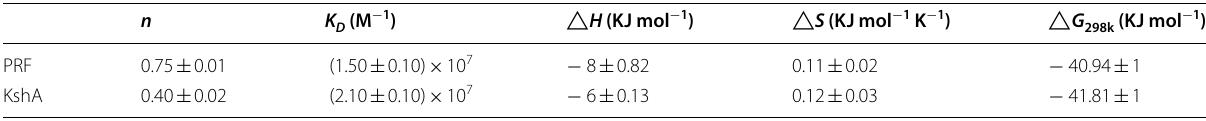
Table 2 Thermodynamic parameters for the interaction with